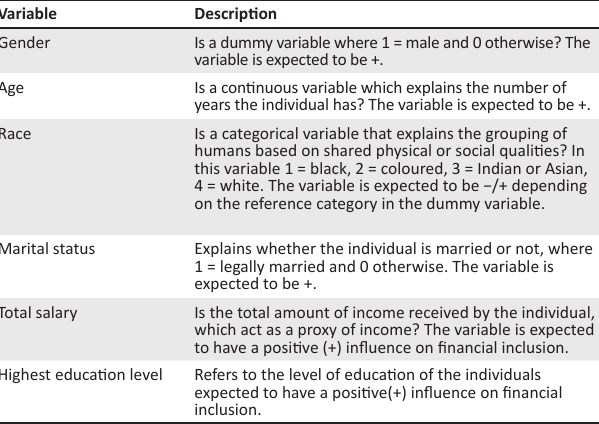
TABLE 1 : Description of independent variables.